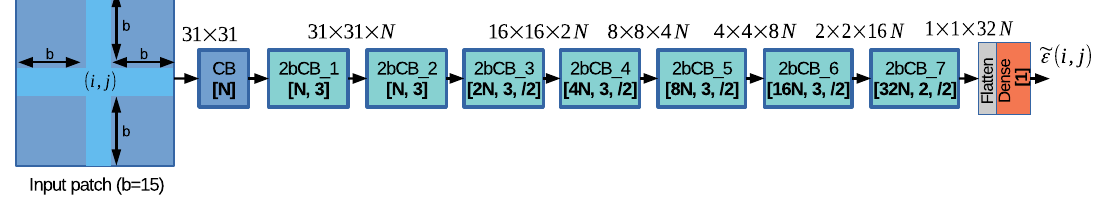
Figure 6. The proposed Depth Residual Error estimation Convolutional Neural Network (DRE-CNN) architecture design.